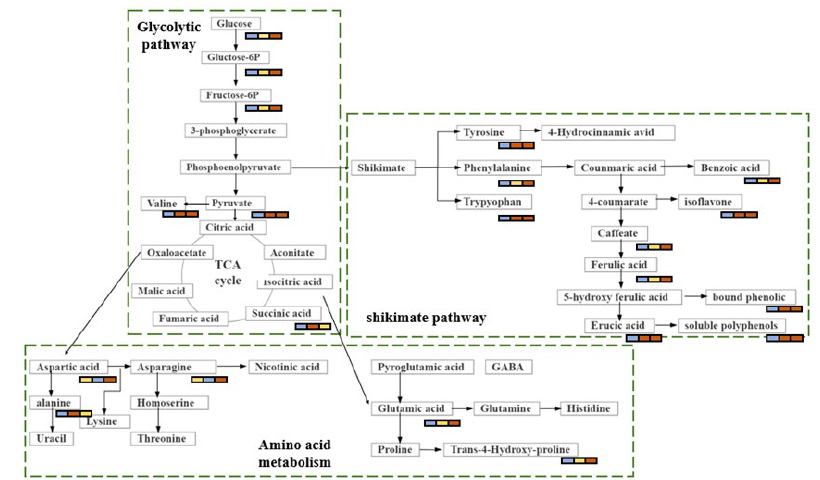
Figure 6. The metabolic changes associated with biochemical pathways.